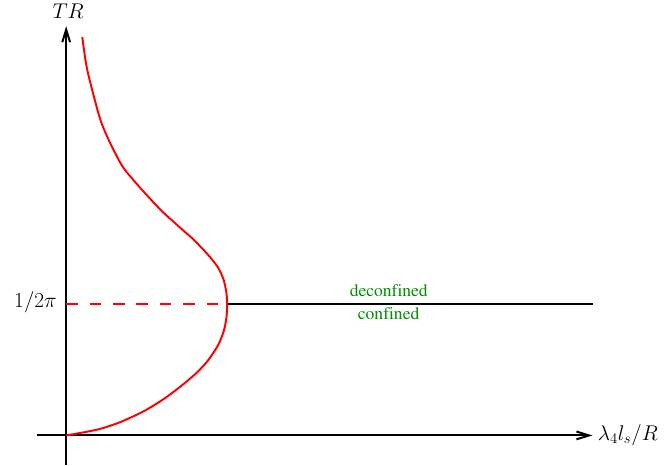
Figure 2 . Possible phase diagram of the compactified D3 brane model as a function of the gauge coupling λ and the 4